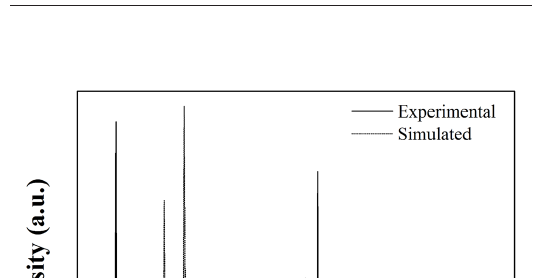
(TFA) (DMSO) ] complex. 2 2 3